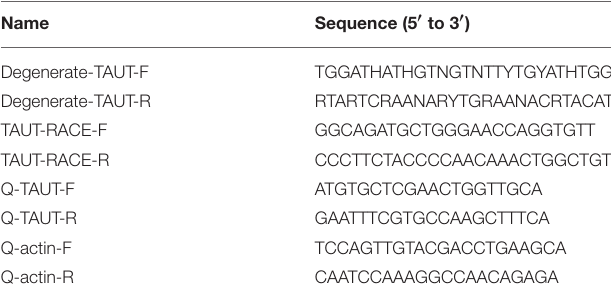
TABLE 1 | Primer sets in the present